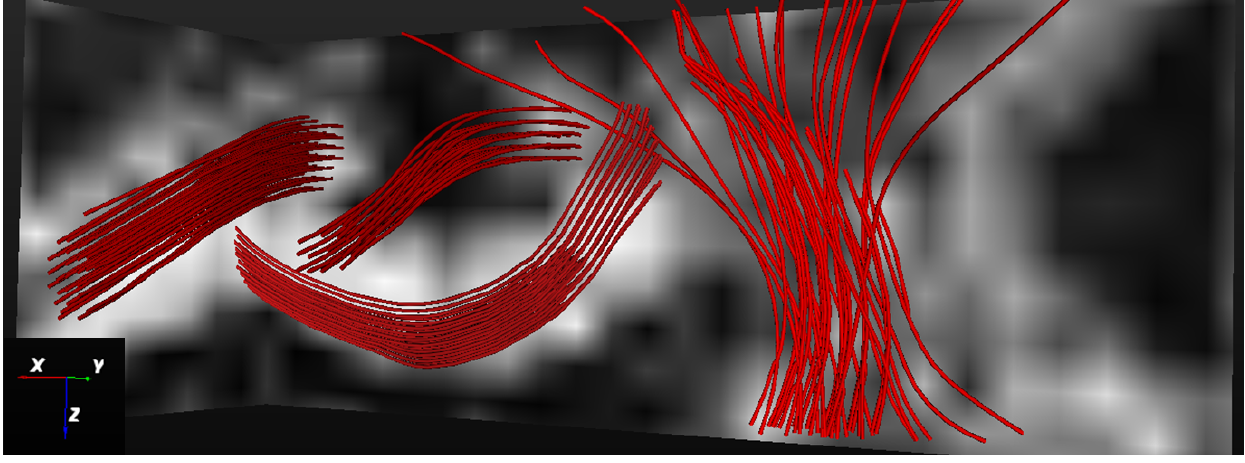
Figure 6. Fiber tracts for corpus callosum (CC), corona radiata (CR) and cingulum